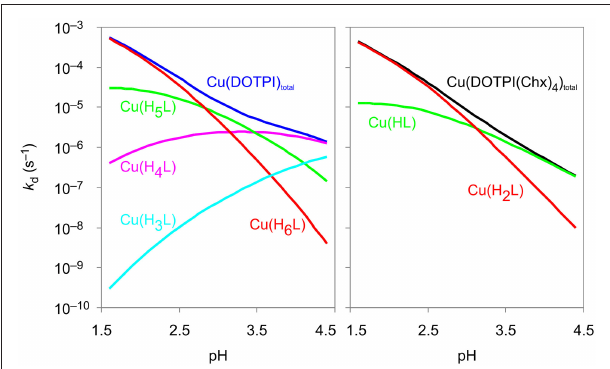
FIGURE 3 | Contributions of Cu(DOTPI) and Cu(DOTPI(Chx) 4 ) complexes in different protonation states to the overall rates of the dissociation reaction.